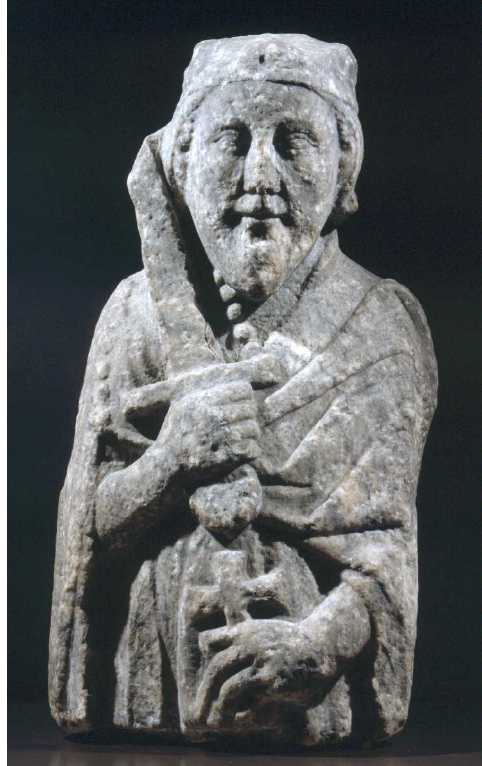
Figure 2. Afonso Henriques (?). 12th or 13th century. From Santarém, currently at the Archaeological Museum of Carmo (Lisbon). Photo: ©José Pessoa/ADF-DGPC.